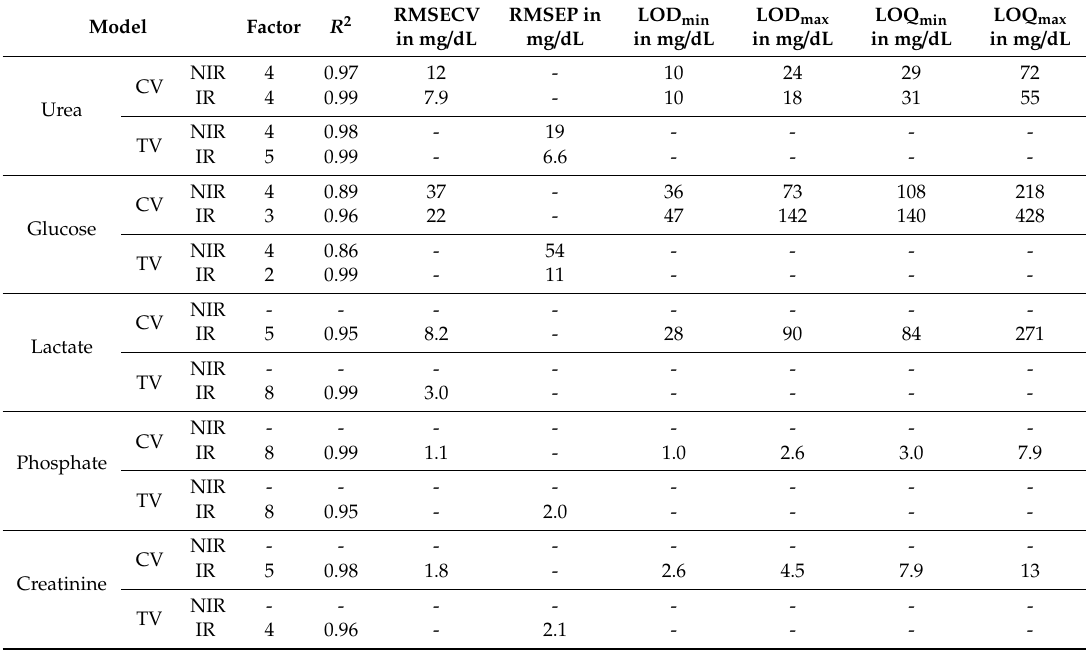
Table 3. Performance parameters of prediction of blood constituents by partial least squares (PLS) regression models developed for IR and NIR spectra of a 5-component model mixture in